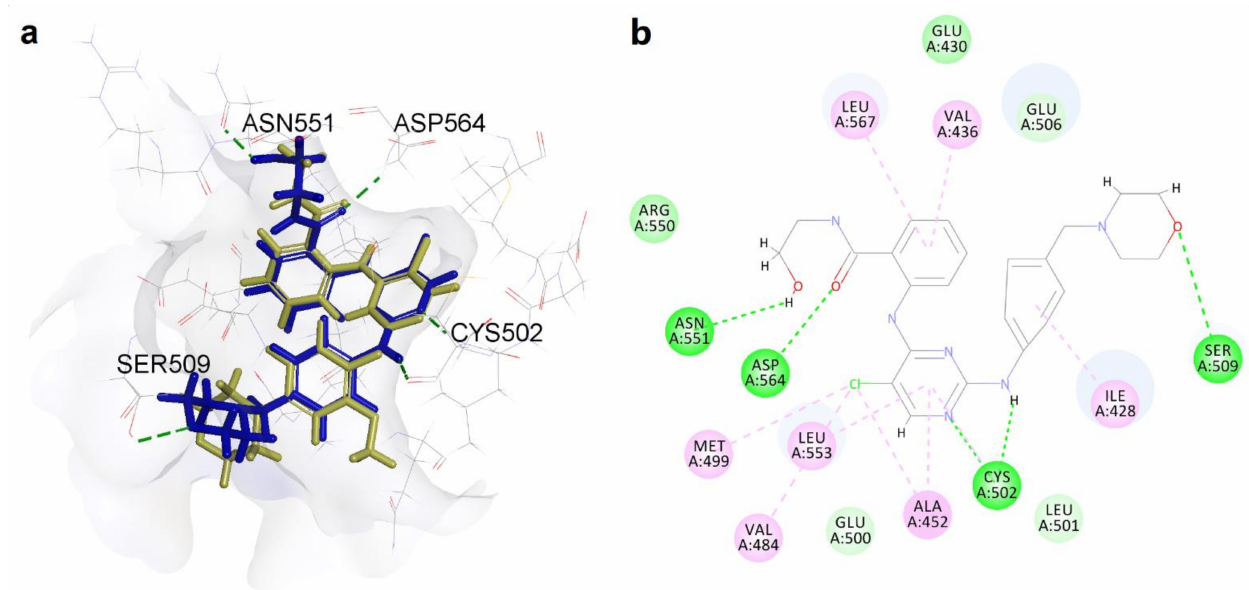
Figure 10. The predicted docked pose of compound 8a in the FAK active site (PDB: 2JKK). ( a ) Image showing the overlap of compound 8a (blue sticks) and TAE226 (yellow sticks). Hydrogen bonds are shown in green dots. ( b ) Interactions between compound 8a and the key residues in the bonding site, where different interactions are shown in different colors. Hydrogen bonds: green; hydrophobic interactions: